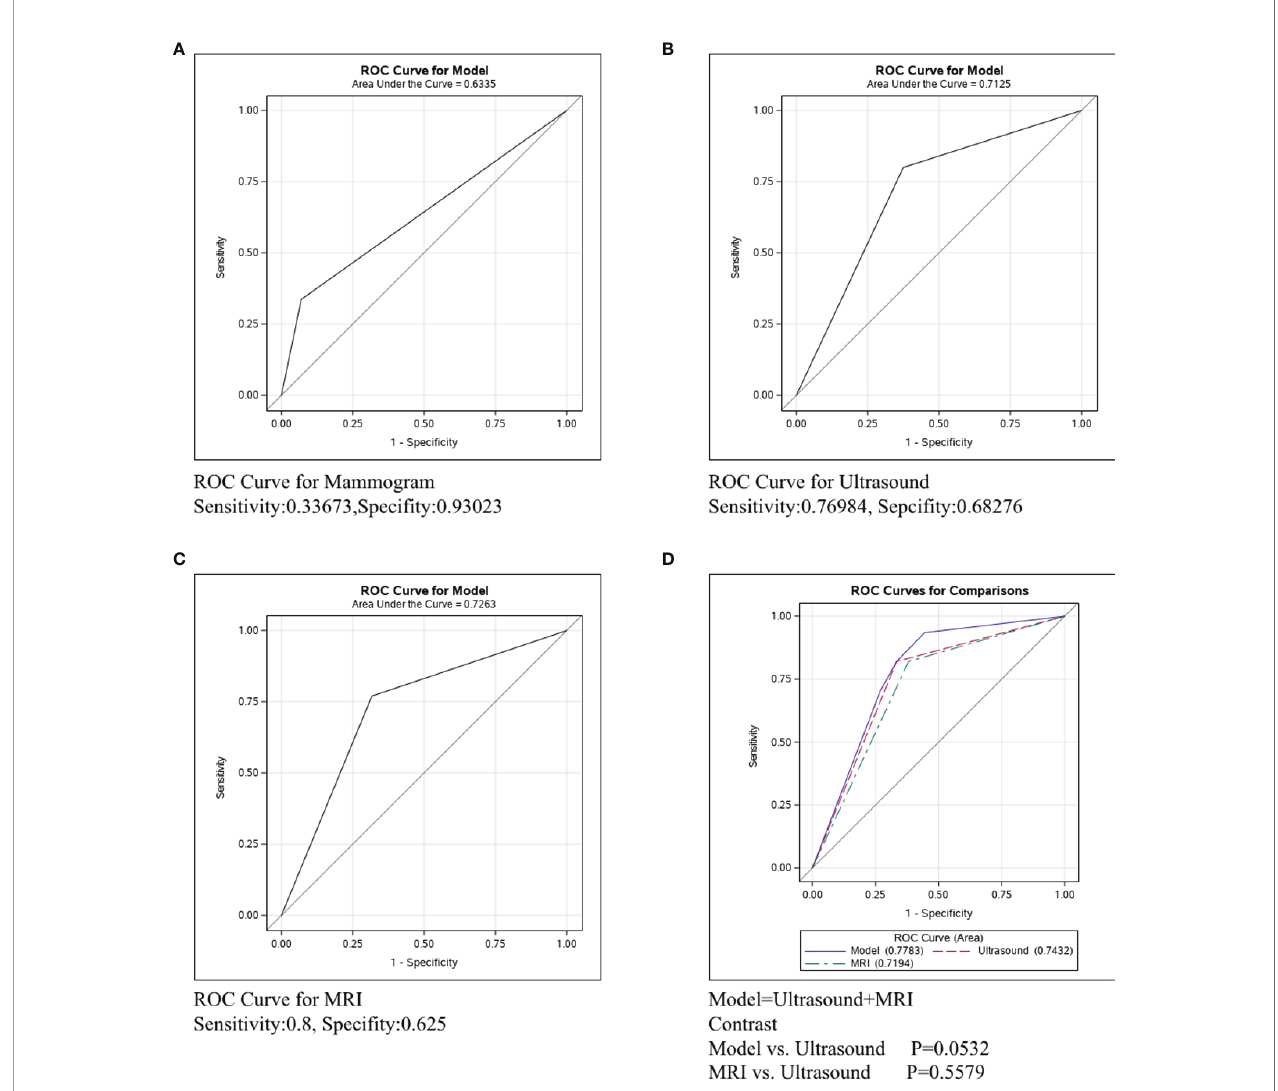
FIGURE 4 | ROC curve analysis for speci fi c imaging examination in ER/PR-Her2- subtype. The vertical axis is sensitivity, the horizontal axis is 1-speci fi city. AUC is a parameter used to measure the value of imaging examination in the prediction of axillary lymph nodes. (A) ROC curve for mammogram. (B) ROC curve for ultrasound. (C) ROC curve for MRI. (D) ROC curve for